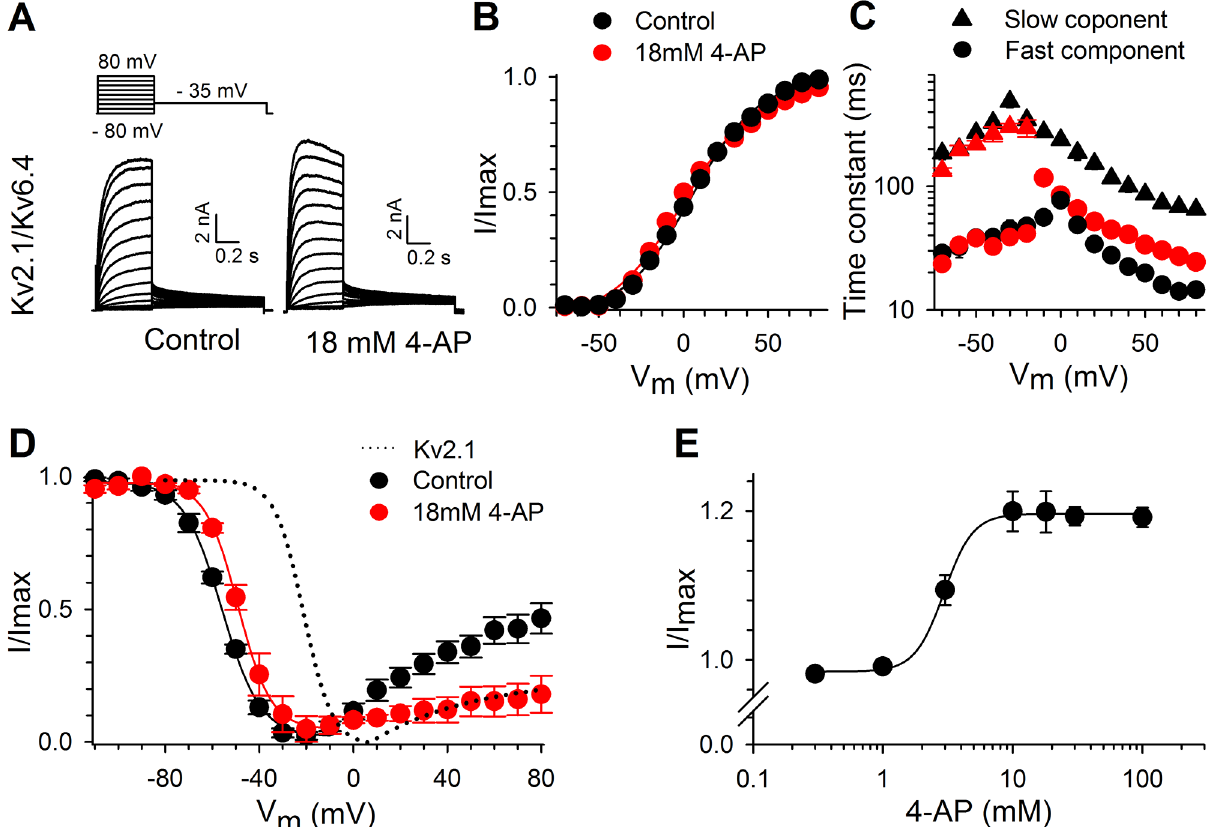
Fig 3. Effect of 4 − AP on the gating properties of Kv2.1/Kv6.4 heterotetramers. ( A) Representative current recordings of Kv2.1/Kv6.4 before (left) and after application of 4 − AP (right). 4 − AP potentiated Kv2.1/Kv6.4 currents and accelerated the activation kinetics. (B) Voltage dependence of activation with (red) and without 4 − AP (black). The voltage dependence of activation was derived from plotting the normalized tail currents in panel A in function of the prepulse potential. (C) Activation and deactivation kinetics of the Kv2.1/Kv6.4 heterotetramers. Time constants were obtained with a double exponential function yielding a fast (circles) and slow (triangles) component under control conditions. 4 − AP (red) abolished the slow component in the activation but left the fast component largely unaffected. (D) The voltage dependence of inactivation before (black) and after application of 4 − AP (red). The voltage − dependence of inactivation was obtained by plotting the normalized peak amplitude at +60mV after a 5s prepulse in function of the prepulse potential. 4 − AP (red symbols) did not significantly alter the voltage dependence of activation but significantly reduced the degree of U − shaped inactivation. For comparison, homomeric Kv2.1 (dotted line) before 4 − AP application is included. (E) Concentration − dependence of the 4 − AP induced potentiation relative to control. The solid line represents a fit with the Hill equation with EC 50 of 3.2 ± 0.2 mM (n =